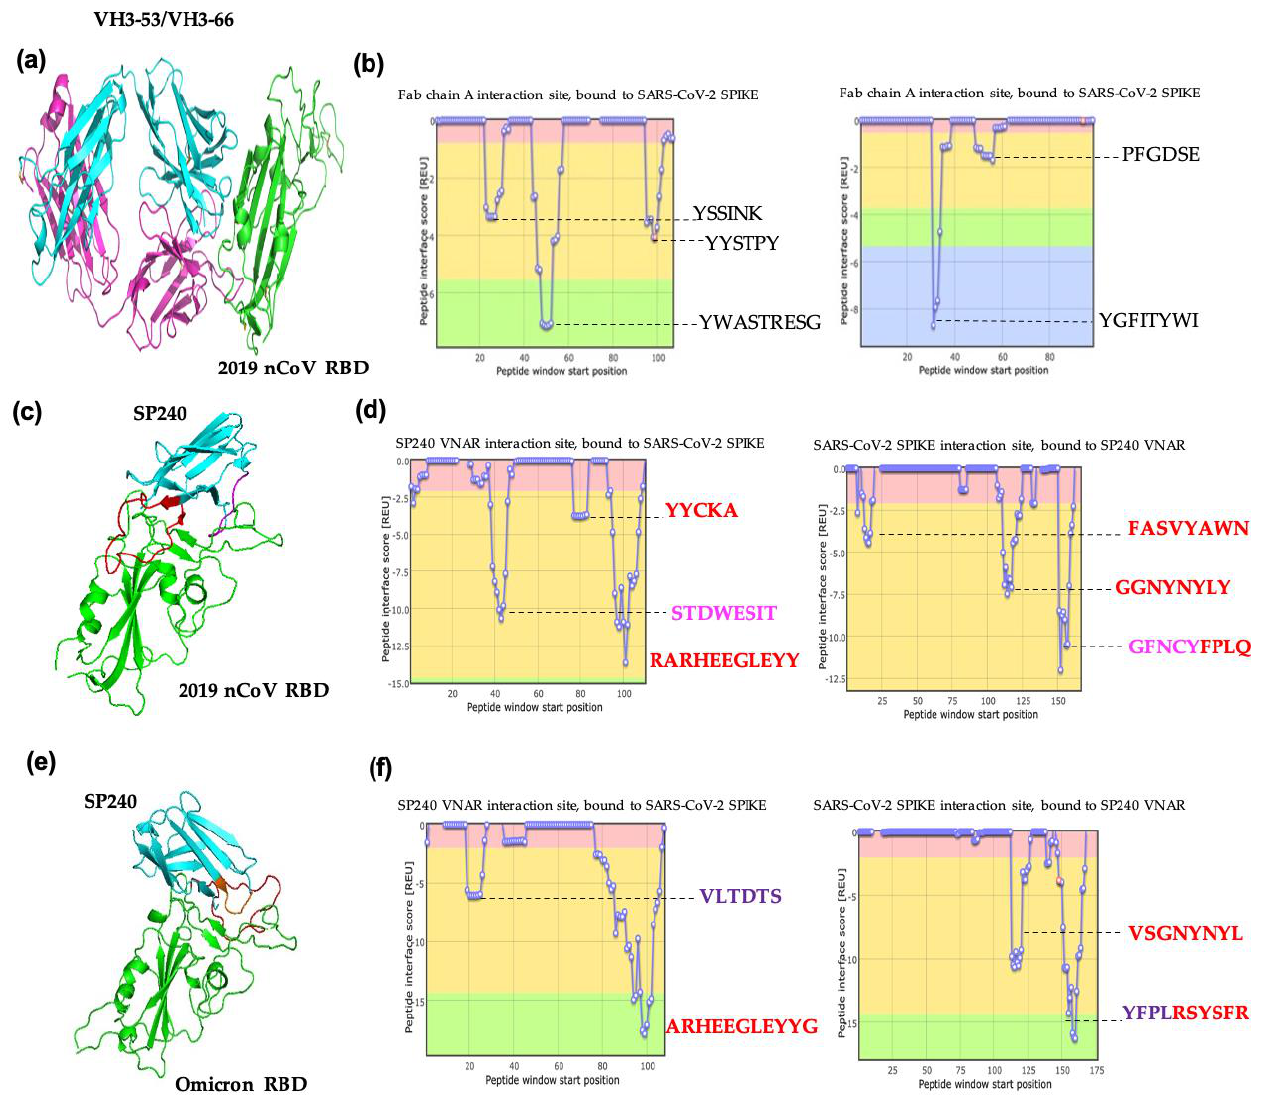
Figure 7. Protein–protein interaction analysis using the Peptiderive web tool. ( a ) Graphic representa- tion of the VH3-53/VH3-66 antibody (cyan and pink) coupled to the RBD (green) of SARS-CoV-2 (2019-nCoV). ( b ) Energy plot for the interaction between the positive control VH3-53/VH3-66 and the RBD of spike protein from SARS-CoV-2 (2019-nCoV). ( c ) VNAR SP240 (cyan) coupled to spike RBD variant 2019-nCoV (green). The CDR3 loop is indicated in red color, and HV2 is shown in pink. ( d ) Energy plot for peptides in VNAR SP240 that bind the RBD of 2019-nCoV. ( e ) VNAR SP240 (cyan) coupled to the Omicron’s RBD (green). The CDR3 loop is shown in red, and the framework section involved in the interaction is indicated in orange. ( f ) Energy plots for VNAR SP240 peptides bound to the Omicron’s RBD. The CDR3 amino acids are indicated in red, HVR2 amino acids in pink, and residues from the VNAR framework in orange. VNAR SP240 sequences interacting with RBD residues are matched with colors.